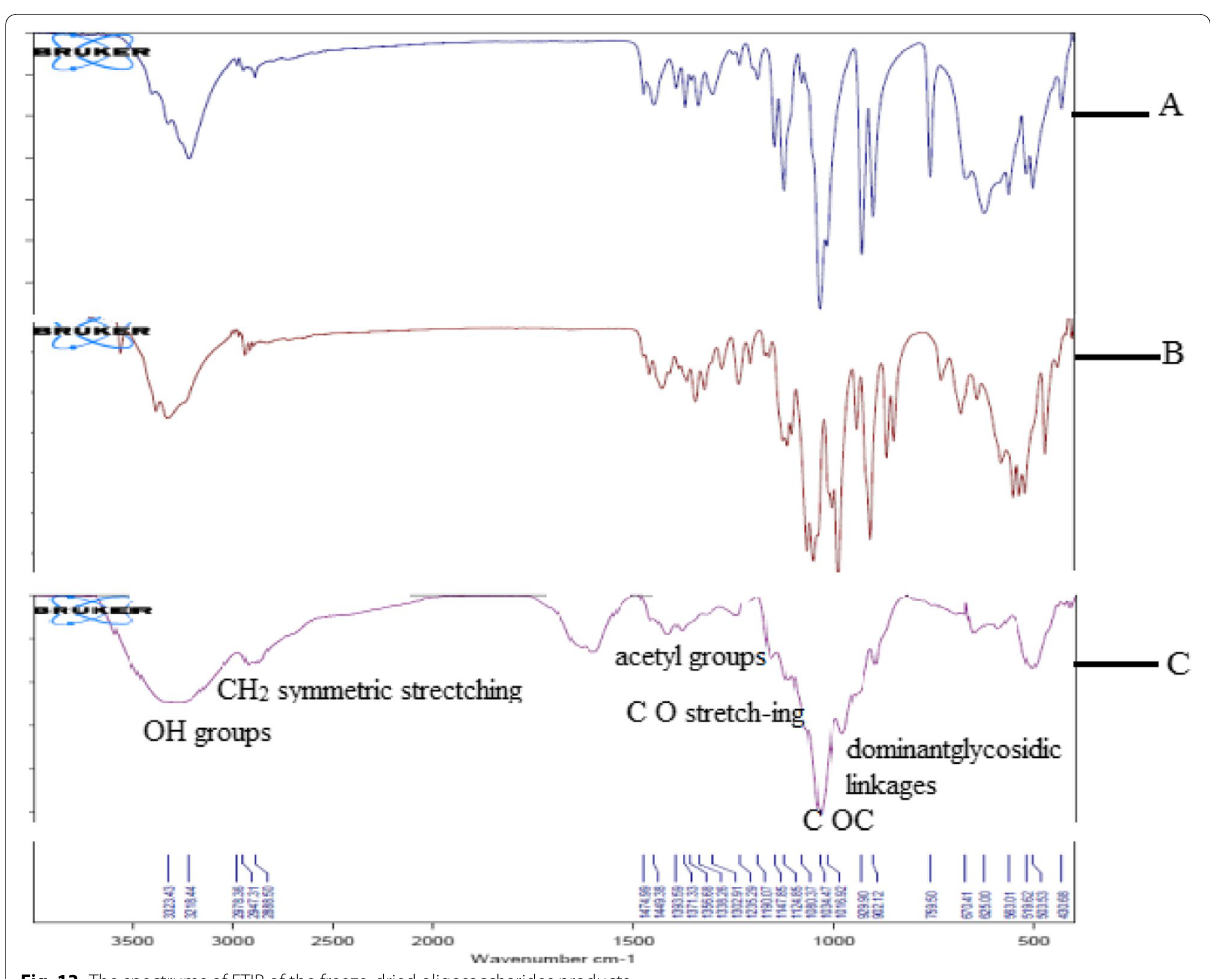
Fig. 13 The spectrums of FTIR of the freeze‑dried oligosaccharides